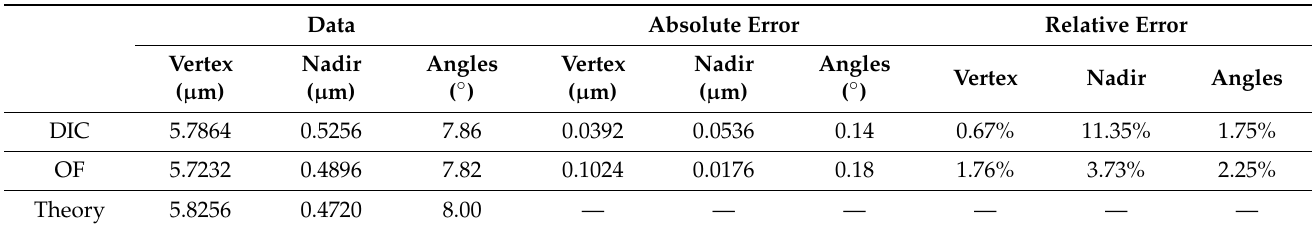
Table 2. Data of vertex and nadir in Figure